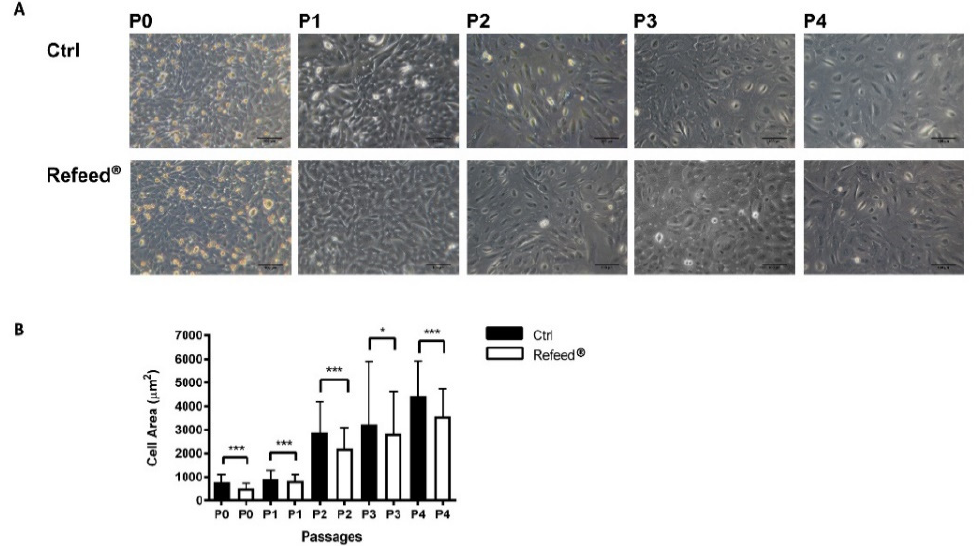
Figure 5. Morphological analysis of human Amniotic Epithelial Cells (hAECs) cultured with and without Refeed ® supplementation. ( A ) Representative images of hAECs cultured in basal medium without (Ctrl) or with Refeed ® were acquired from passages P0 to P4 using a Leica Labovert FS inverted Microscope equipped with a Leica MC170 HD digital camera. Scale bars = 100 µ m. ( B ) Analy- sis of the hAEC area ( µ m 2 ) during in vitro passages (P0–P4) in basal medium (Ctrl) and with Refeed ® . Data are expressed as mean ± standard deviation (SD) (* p < 0.05, *** p < 0.001). The experiment was performed on three human samples in technical